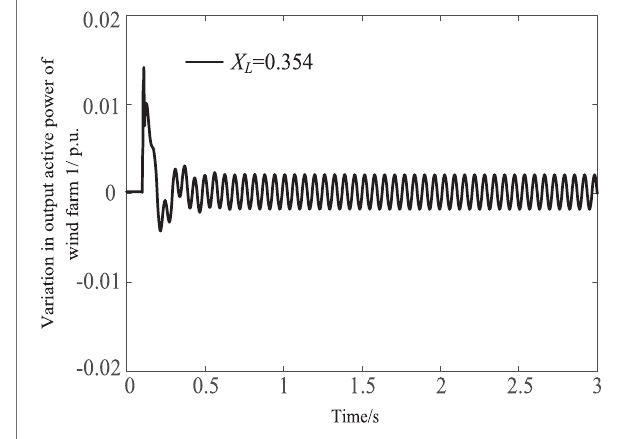
FIGURE 11 | Nonlinear simulation results of critical stable state.